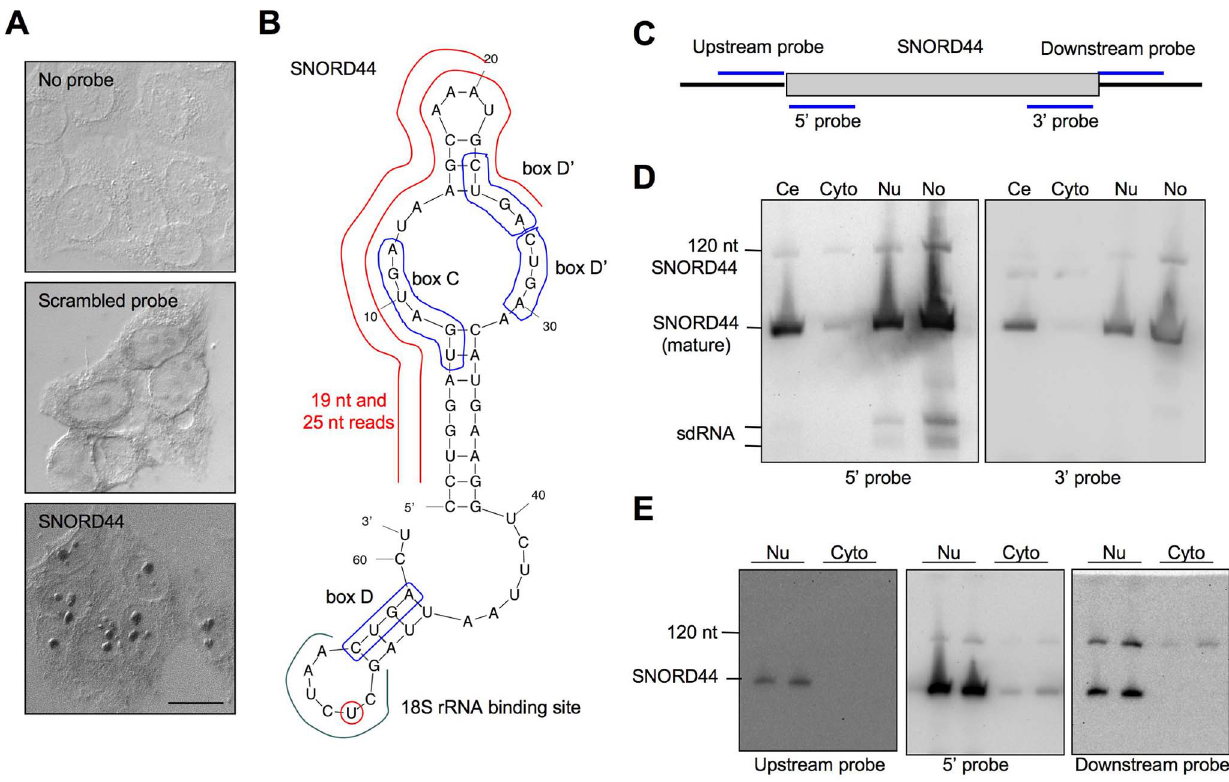
Figure 4. Analysis of SNORD44 sdRNAs. A SNORD44 in situ hybridization with the indicated probes. Differential interference contrast images. Scale bar 20 m m. B Predicted secondary structure of the mature SNORD44 (MFold). Positions of box C/C’ and box D/D’ and 18S RNA binding site are indicated. Red lines show 19 nt and 25 nt sdRNA read locations. C SNORD44 probes used for Northern hybridization. D Northern analysis of SNORD44 expression in the cell subcompartments using 5 9 ( left ) or 3 9 ( right ) SNORD44 probes. Ce, whole cell; Cyto, cytoplasmic, Nu, nuclear; No, nucleolar. E Northern analysis of SNORD44 expression in nuclear and cytoplasmic RNA fractions using the indicated probes. An equal amount of each RNA preparation (25 m g) was loaded in duplicate. Note that the SNORD44 signal in the hybridizations with the upstream and downstream probes is a bleed through of the earlier probing with the mature 5 9 probe.